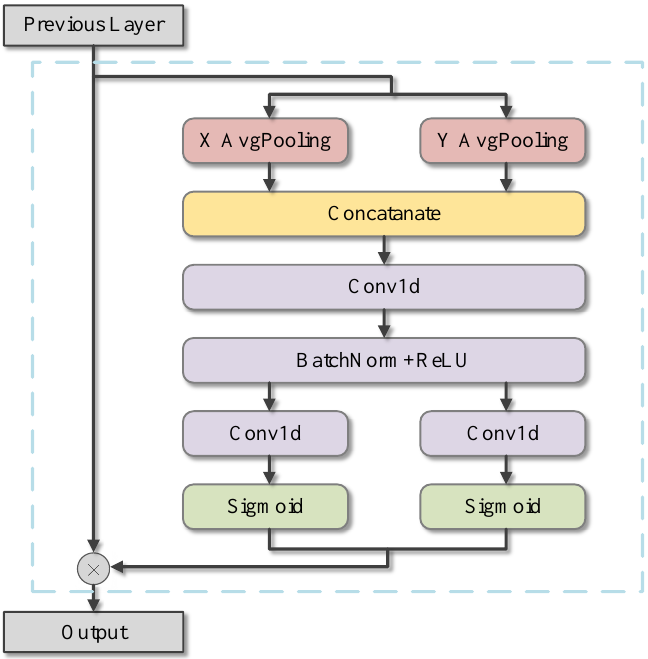
Figure 2. The structure of the attention fusion module.